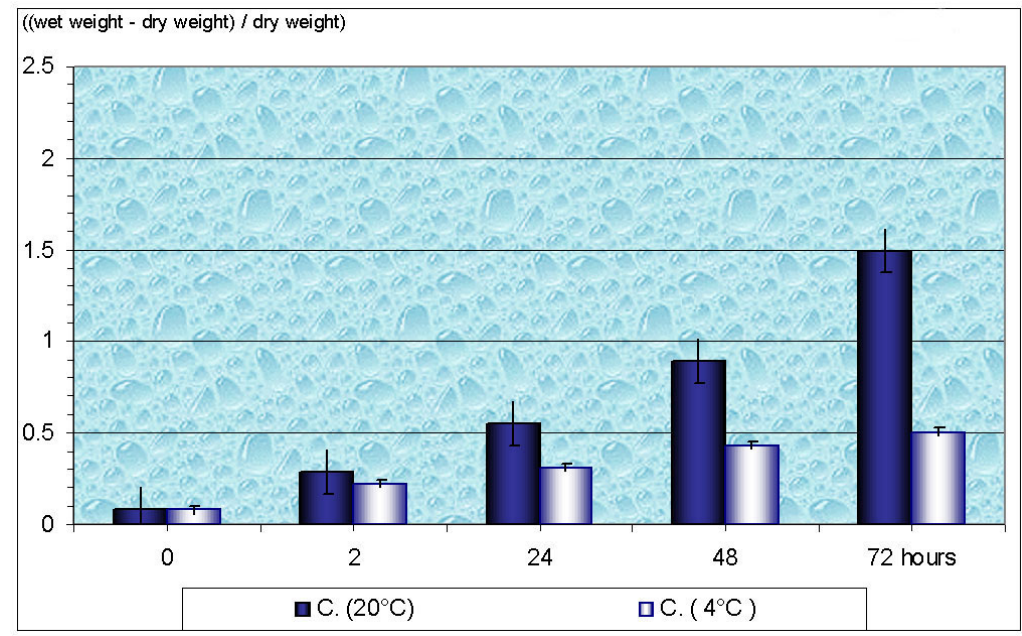
FIGURE 2A. The time-dependent seed hydration in nontreated DW in cold and warm conditions. On abscissa, the time (in hours) of seeds incubation; on ordinates, value of seed hydration (mg of H 2 O for 1 mg of dry weight) are presented.